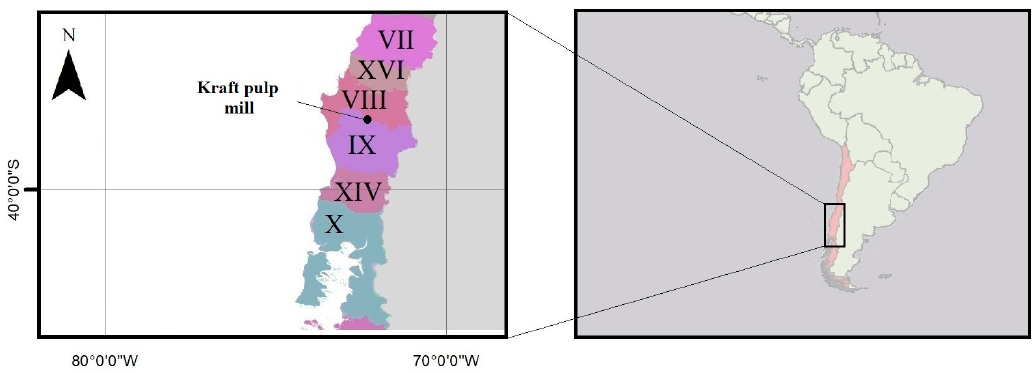
Figure 1. Location of the kraft pulp mill.